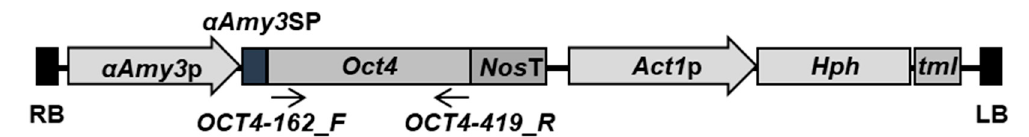
Figure 1. Schematic representation of the human Oct4 expression cassette in transgenic rice plants. The human Oct4 cDNA was inserted downstream of the α Amy3 promoter ( α Amy3 p)–signal peptide ( α Amy 3SP) sequence. Expression of the hygromycin phosphotransferase resistance ( Hph ) gene was driven by an actin promoter ( Act1 p), and the terminator of the Agrobacterium tml gene was used. RB, T-DNA right border; Nos T, Nopaline synthase terminator; LB, T-DNA left border. Two primers used to amplify the inserted Oct4 gene were designated OCT4-162_F and OCT4-419_R.